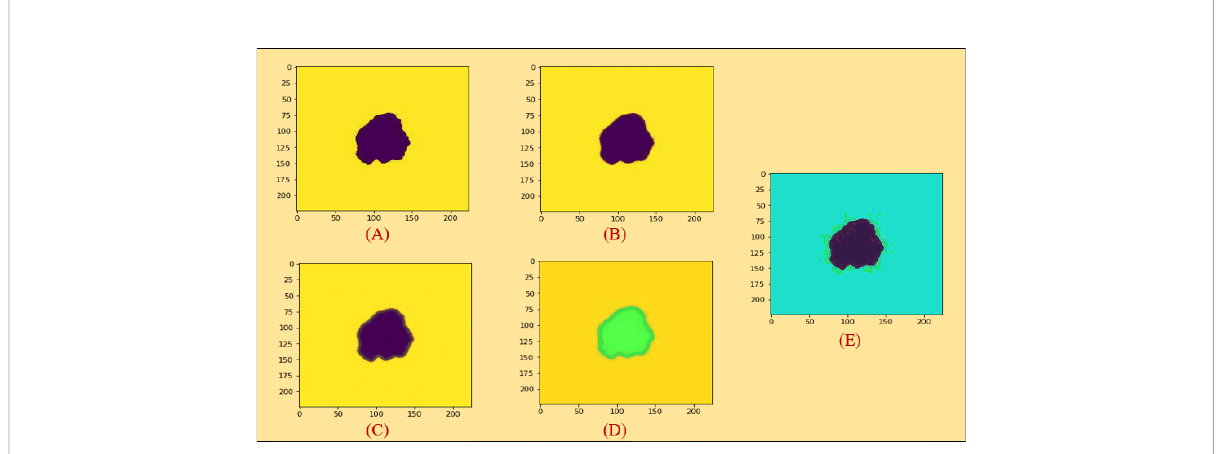
FIGURE 4 (A) Piecewise linear transformation on the non-local means denoising algorithm. (B) Piecewise linear transformation on the median fi lter. (C) Piecewise linear transformation on the Gaussian fi lter. (D) Piecewise linear transformation on the mean fi lter. (E) Piecewise linear transformation on the conservative fi